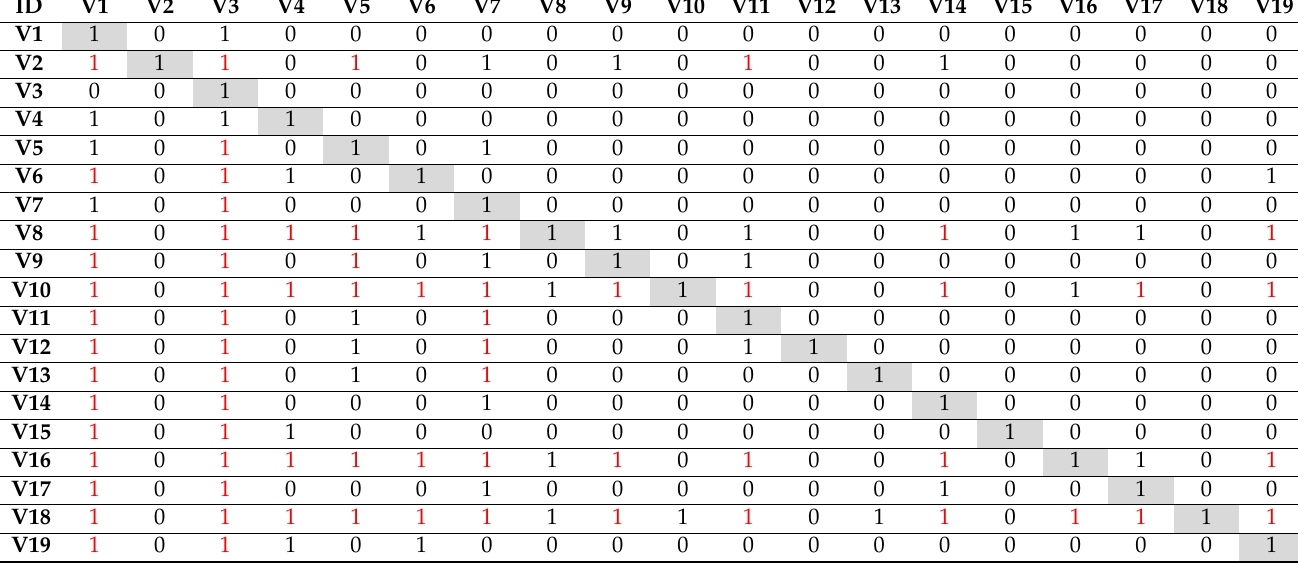
Table 3. Final reachability matrix (FRM).